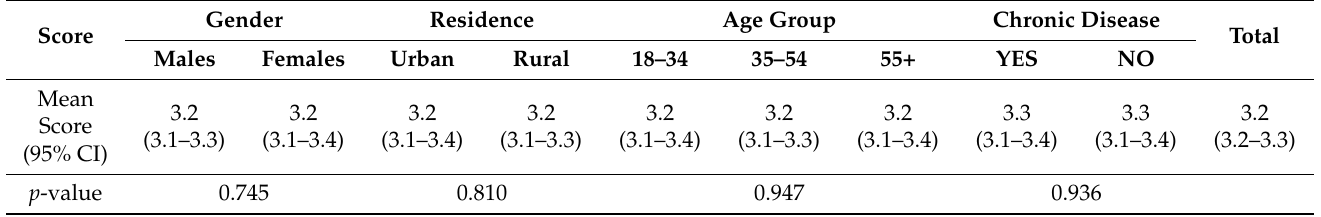
Table 5. Satisfaction with health care in the adult population of Bosnia and Herzegovina during the COVID-19 pandemic by selected